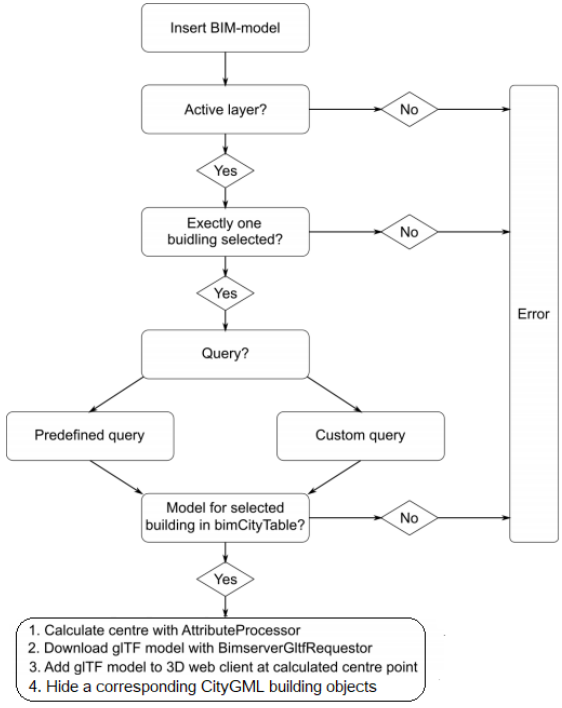
Figure 10: Sequence of conditions and tasks that are executed by the main function that was added to the script.js. This function is the link between the script.js, the bimCityTable (section 3.1), the AttributeProcessor (section 3.2) and the BimserverGltfRequestor (section 3.3).